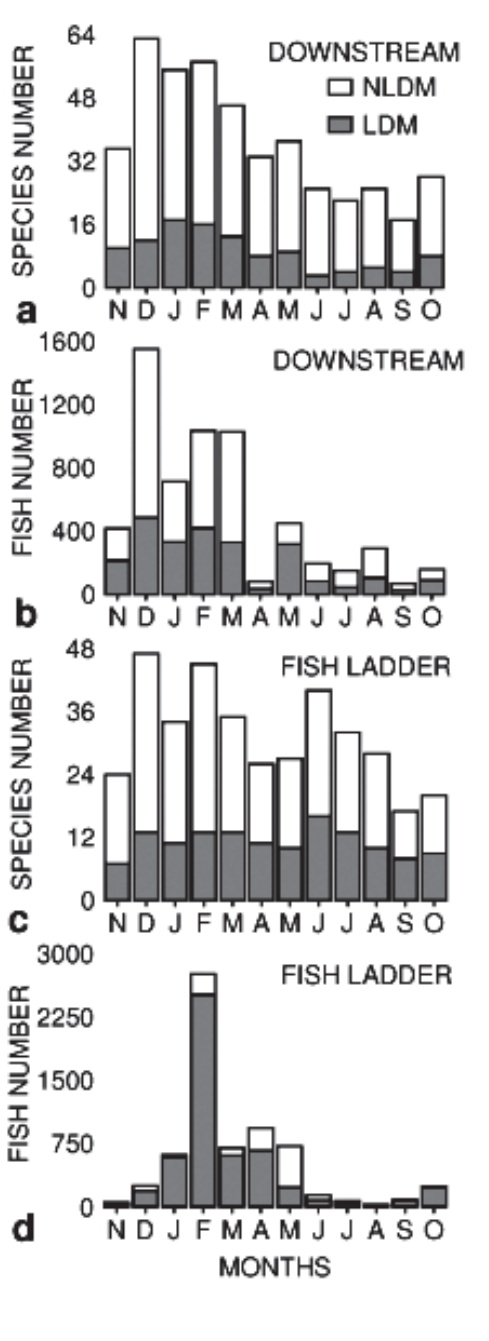
Fig. 1. Number of species and abundance of individuals downriver (a and b; fish.1000 m -2 gillnet.24 hours -1 ) and in the ladder (c and d; fish.100 casts -1 ), from November, 2002 through October, 2003, according to reproductive strategy (MLD = long-distance migrants ; NMLD = sedentary/short-distance migrants), at Lajeado Dam.